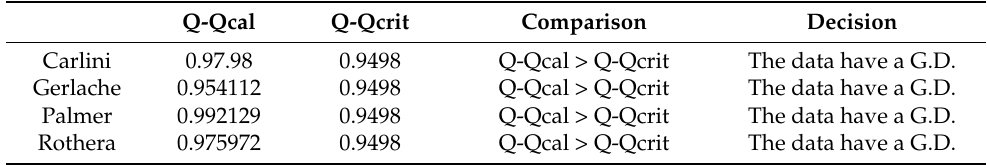
Figure 3. Dendrogram of the correlation analysis of the time series of localities based on Pearson’s correlation coefficient as a similarity function and the average linkage clustering method. As the time series of each locality shows a Gaussian distribution (Table 2), the forma- multiple comparisons of variances (Table 3). Table 2. Results of the Q-Q test for the Gaussian distribution of each series ( n = 20 and alpha error = 5%). In the Decision column, the Gaussian distribution is denoted as G.D.